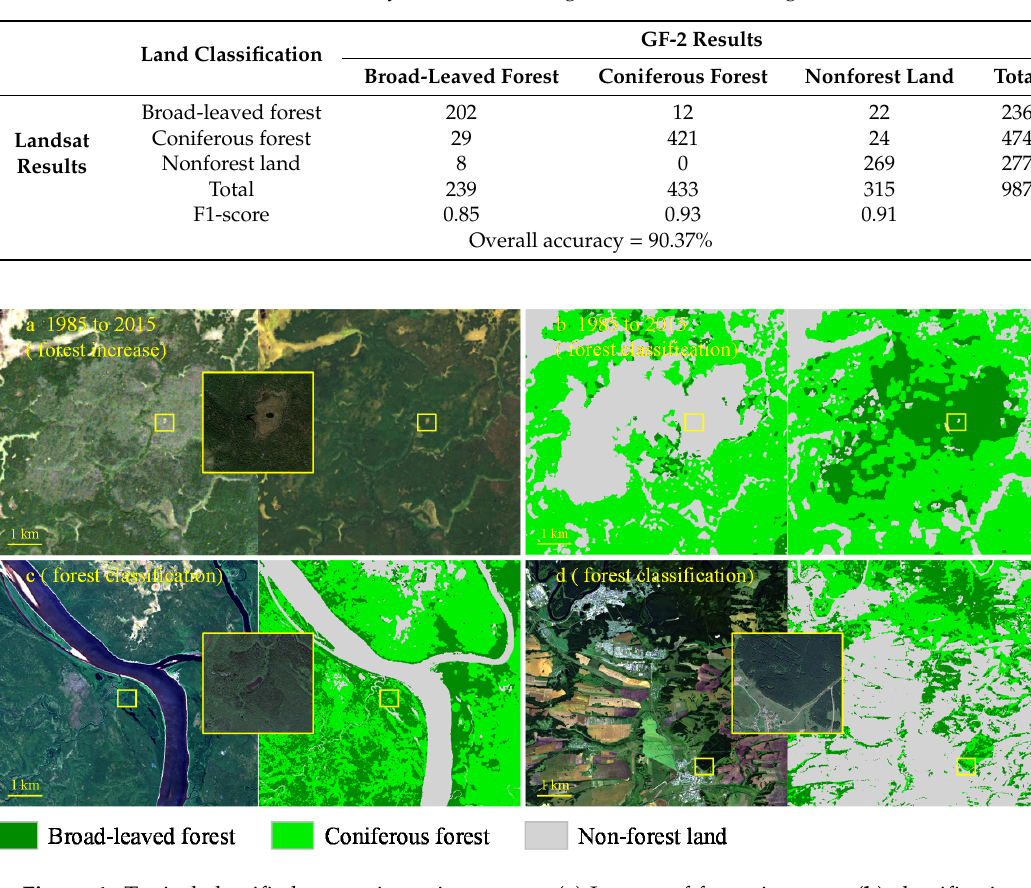
Figure 4. Typical classified scenes in various areas. ( a ) Images of forest increase; ( b ) classification results of the images in ( a ); ( c , d ) forest classification results in different